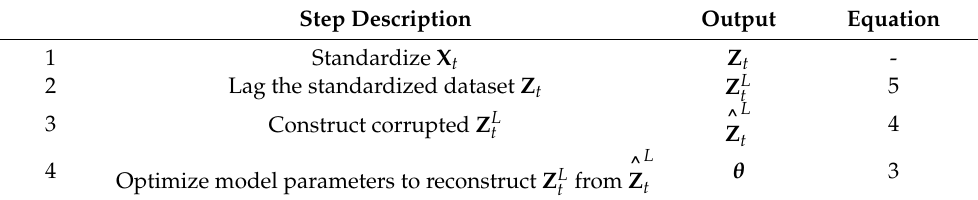
Table 4. Model derivation algorithm for both AE and CAE.